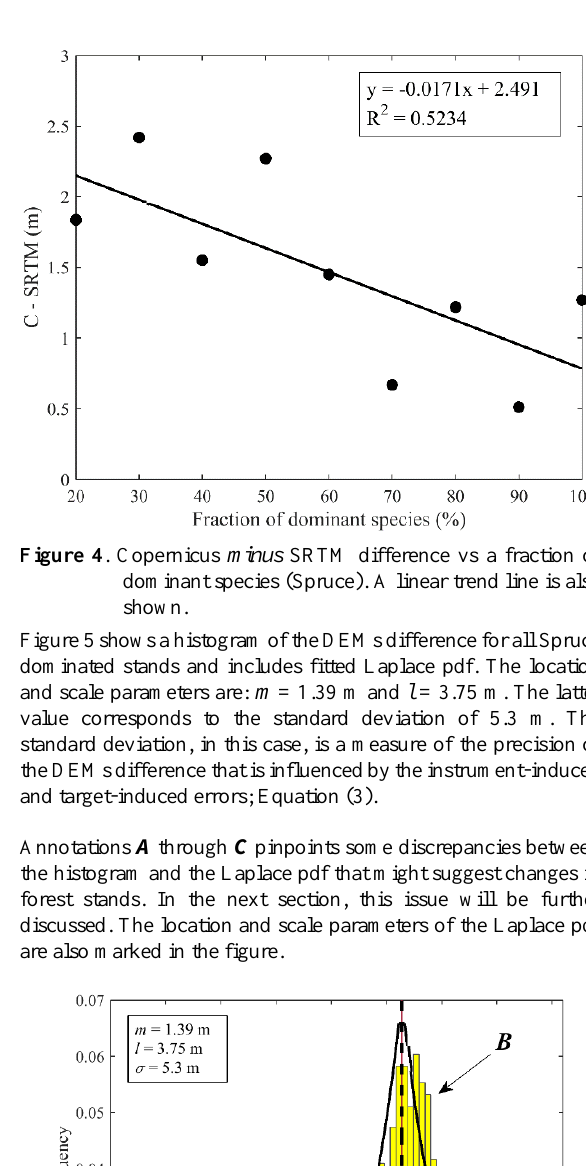
dominant species. A trend line is also shown. The difference approximately 60 indicates timber extraction